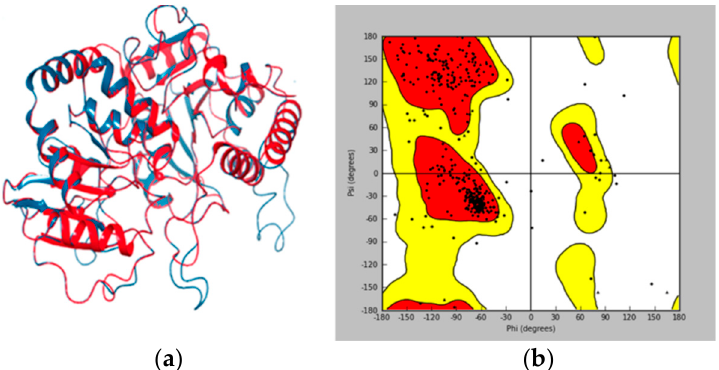
Figure 3. Homology model validation. ( a ) RMSD between the template (in blue) and target protein (in red). ( b ) Ramachandran (phi/psi) plot. Red: favorable region; yellow: allowed region; white: disallowed region.